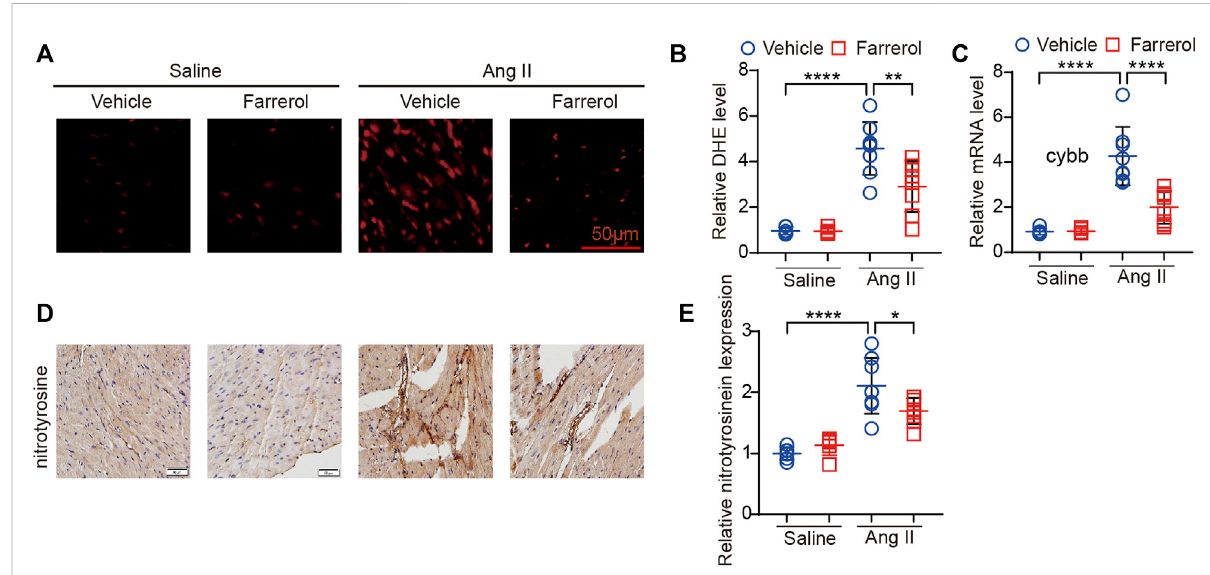
FIGURE 4 Farrerol inhibits Ang II-induced oxidative stress in mice. (A) Representative images of hearts stained with DHE; (B) The relative value of DHE of miceineachgroup; (C) ThemRNAlevelof cybb ineachgroup; (D) Representativeimagesofheartsstainedwithnitrotyrosine; (E) Therelativevalueof nitrotyrosine of mice in each group (Salline = 6, Farrerol = 6, Ang II = 8, Ang II + Farrerol = 8).